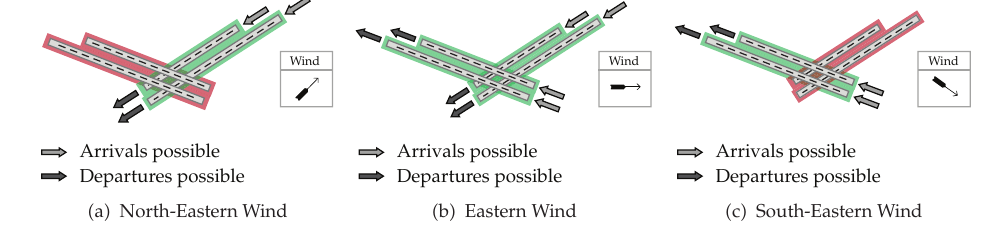
Figure 6: Wind e ff ects on availability of airport